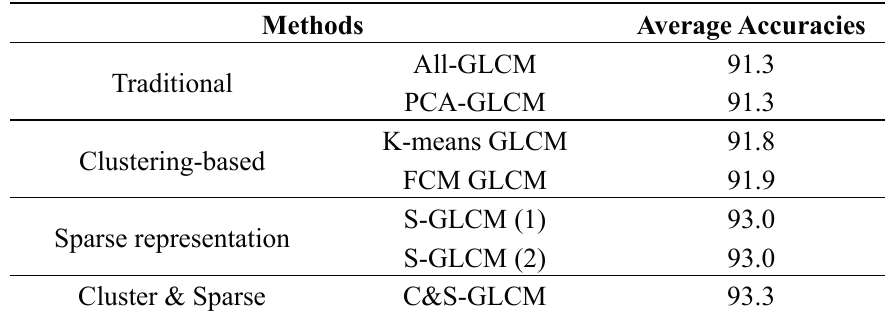
Table 8. The average accuracies (OA%) of each technique over the 14 window sizes and four quantization levels for the QuickBird Wuhan